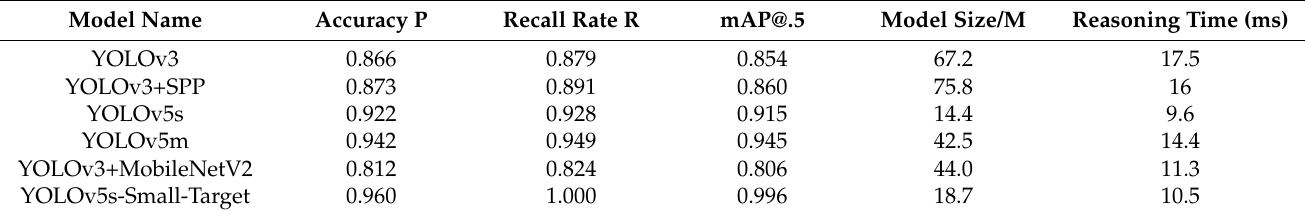
Table 3. Comparison of detection results of each algorithm.